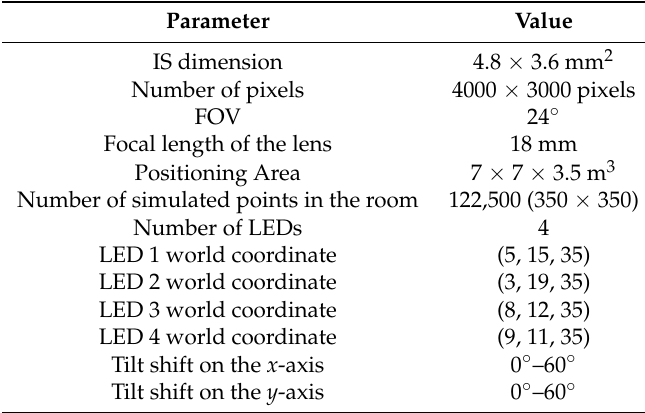
Table 1. Simulation